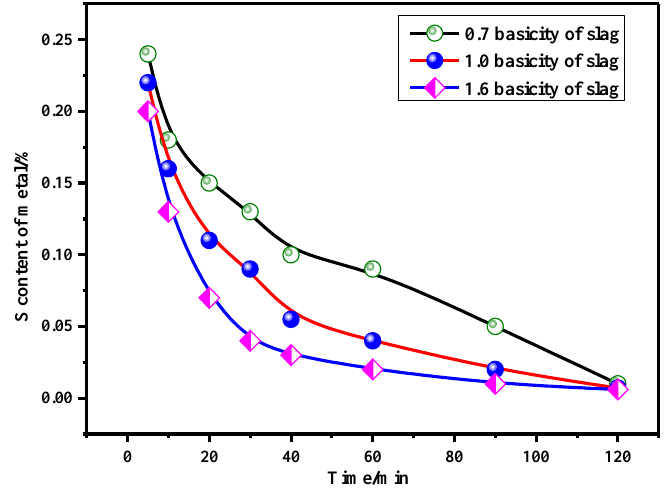
Figure 11. Effects of time and basicity on S content of metal (Smelting temperature 1550 °C).